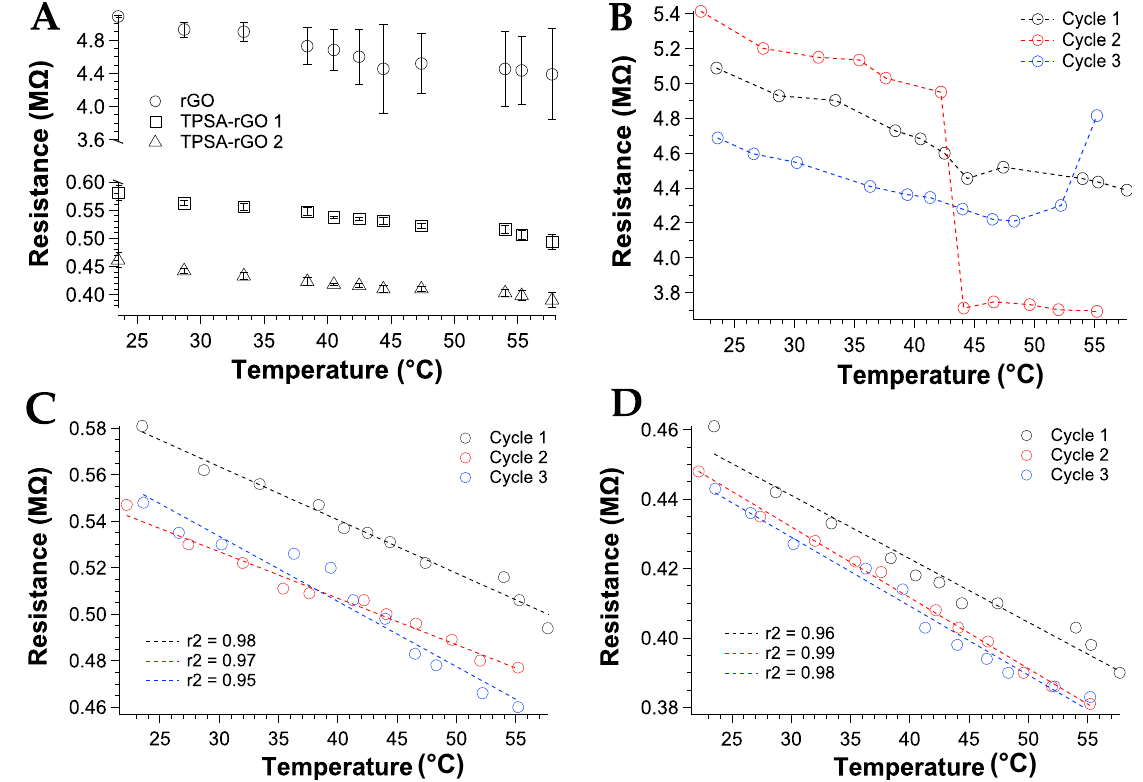
Figure 8. Resistance variation as a function of the temperature: ( A ) first heating cycle for rGO and TPSA-rGO samples; all heating cycles for ( B ) rGO, ( C ) TPSA-rGO 1 with linear interpolation, and ( D ) TPSA-rGO 2 with linear interpolation. As insets, the r2 values of the linear fit were reported.